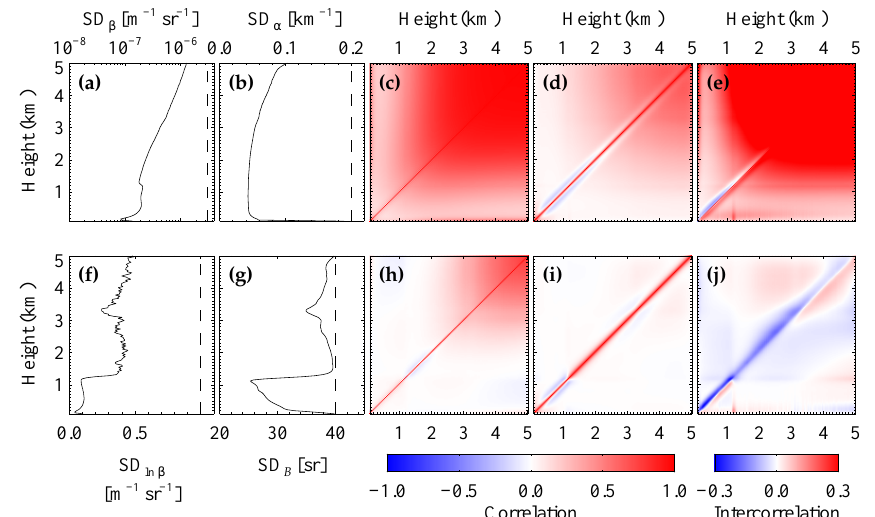
Fig. 14. As Fig. 8, but for real data from case (1) of Fig. 13. The large error correlations are a function of parameter error in E B , which affects all levels equally and becomes dominant as the SNR decreases.